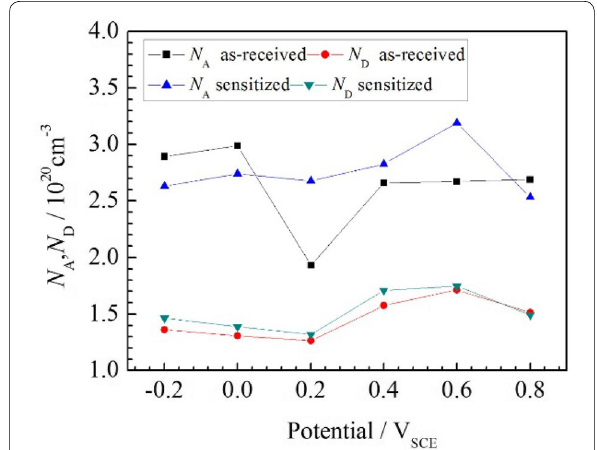
Figure 7 Doping density of the passive film for both specimens between 0.2 and 0.8 V SCE in borate buffer −